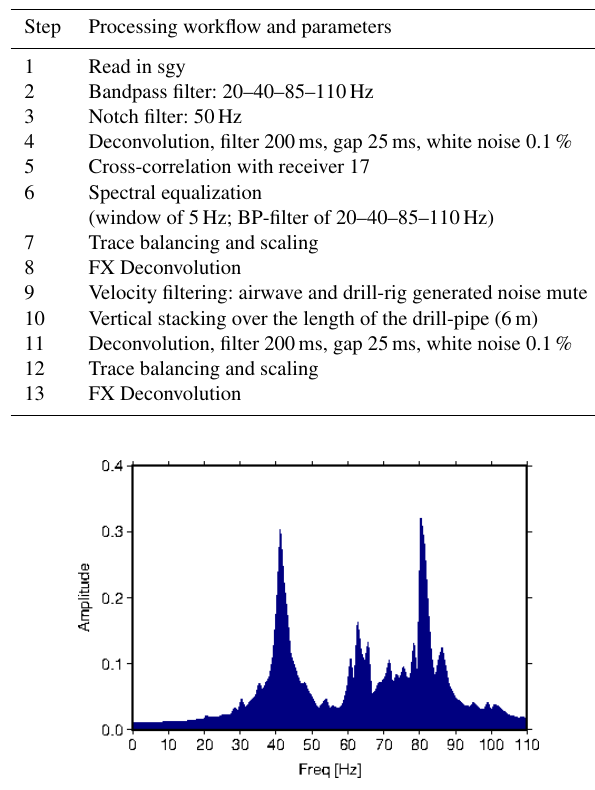
Table 1. The data processing workflow.